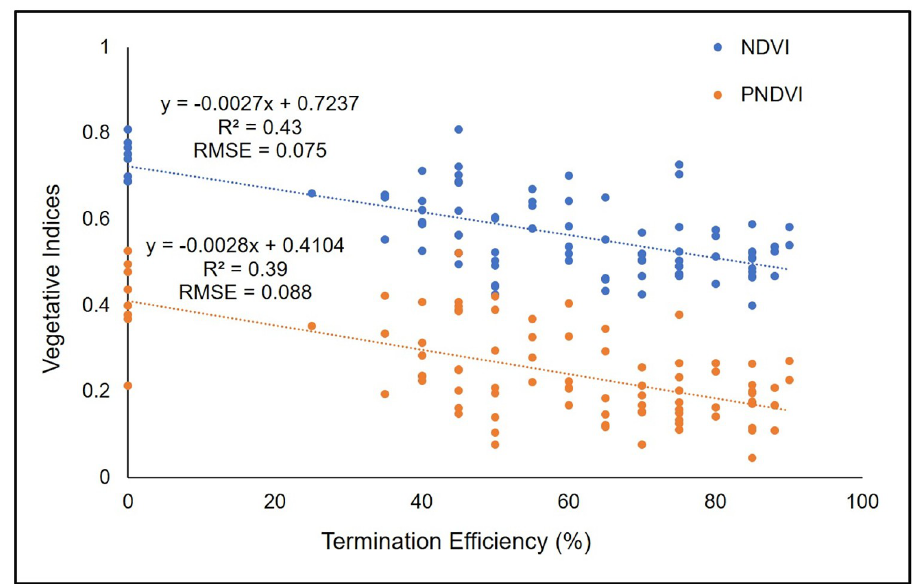
Fig 7. Scatter plot of Normalized Difference Vegetation Index (NDVI) and Pan Normalized Difference Vegetation Index (PNDVI) response to termination efficiency (n = 88 for each vegetative indices) in rapeseed. R 2 = Coefficient of determination, RMSE = Root Mean Square